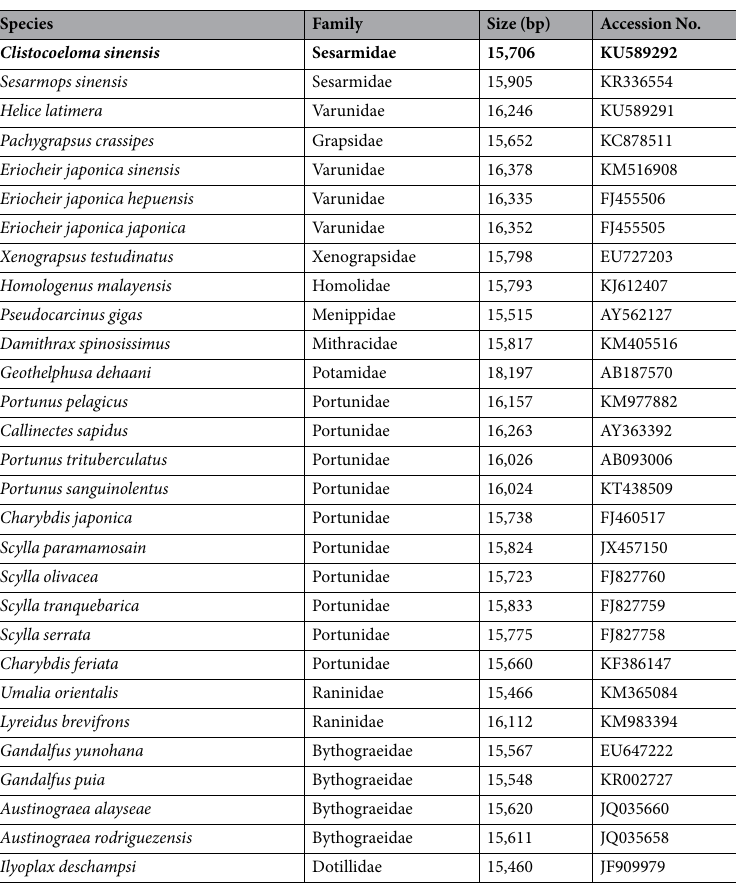
Table 2. List of Brachyura species analysed in this study with their GenBank accession